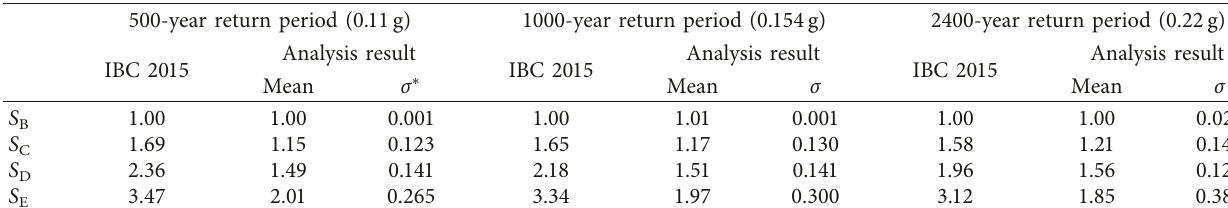
Table 4: Midperiod amplification factor